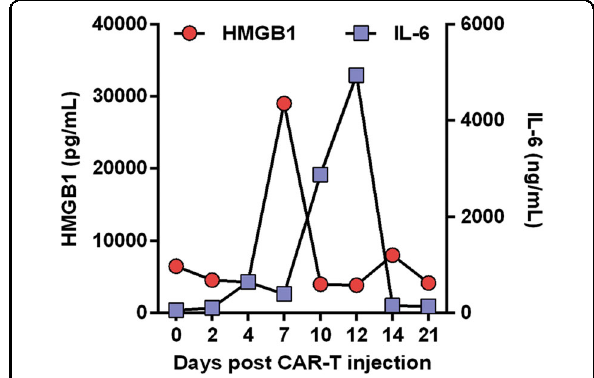
Fig. 1 Time course of HMGB1 and IL-6 release post-CAR-T injection. Sera HMGB1 and IL-6 levels of 10 acute lymphoblastic leukemia patients with CAR-T therapy were detected using ELISA kit (SEA399Hu, Cloud-Clone Corp.) and CBA kit (551811, BD) respectively. The representative time-course is presented.